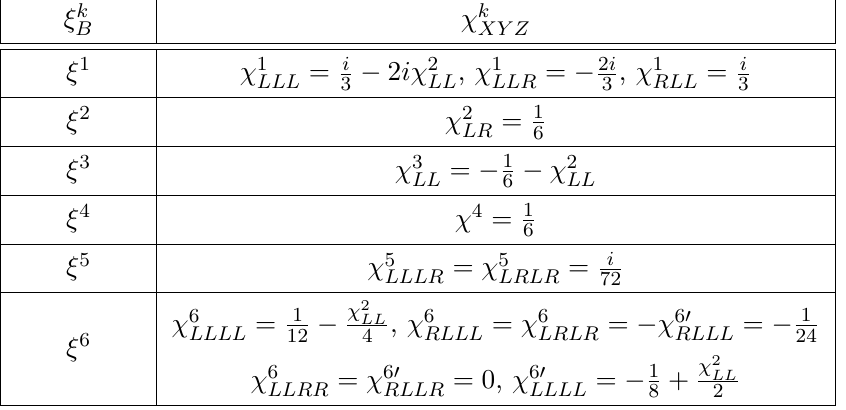
parametrization B